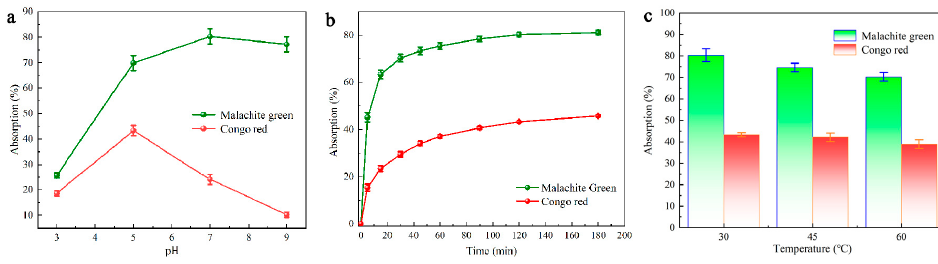
Figure 4. CR and MG adsorption on ( a ) effect of pH, ( b ) effect of time, ( c ) effect of temperature.